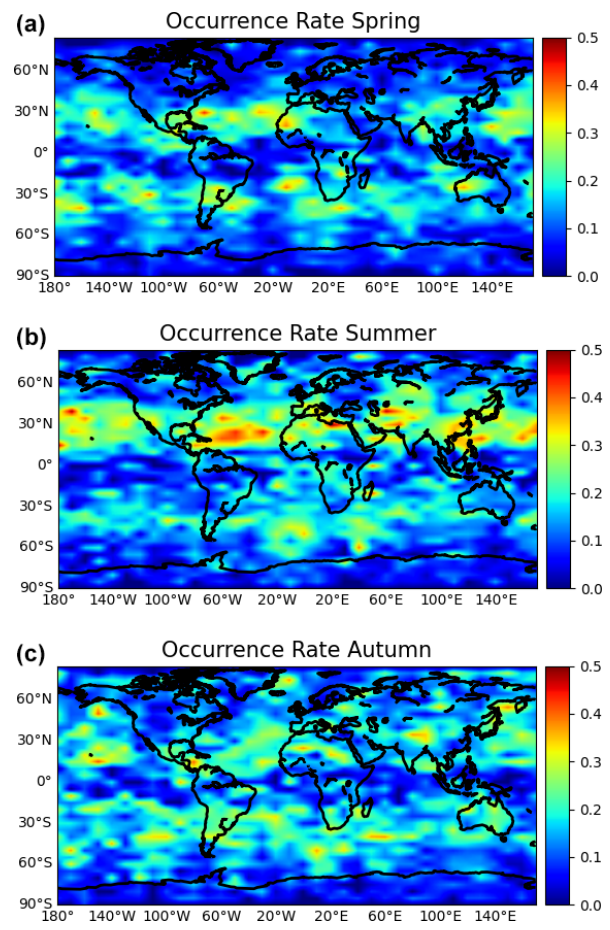
Figure 4. The geographical distribution of E s occurrence rate for three different seasons in 5 ◦ × 10 ◦ geographic latitude/longitude grid. Panels (a–c) are the results of spring, summer, and autumn,